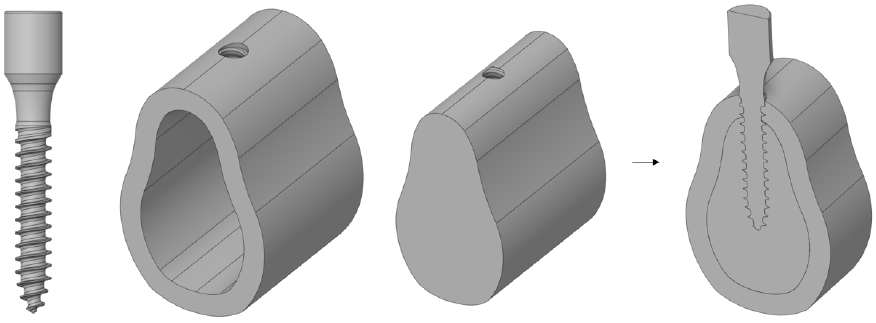
Figure 2. The components of the implant body.